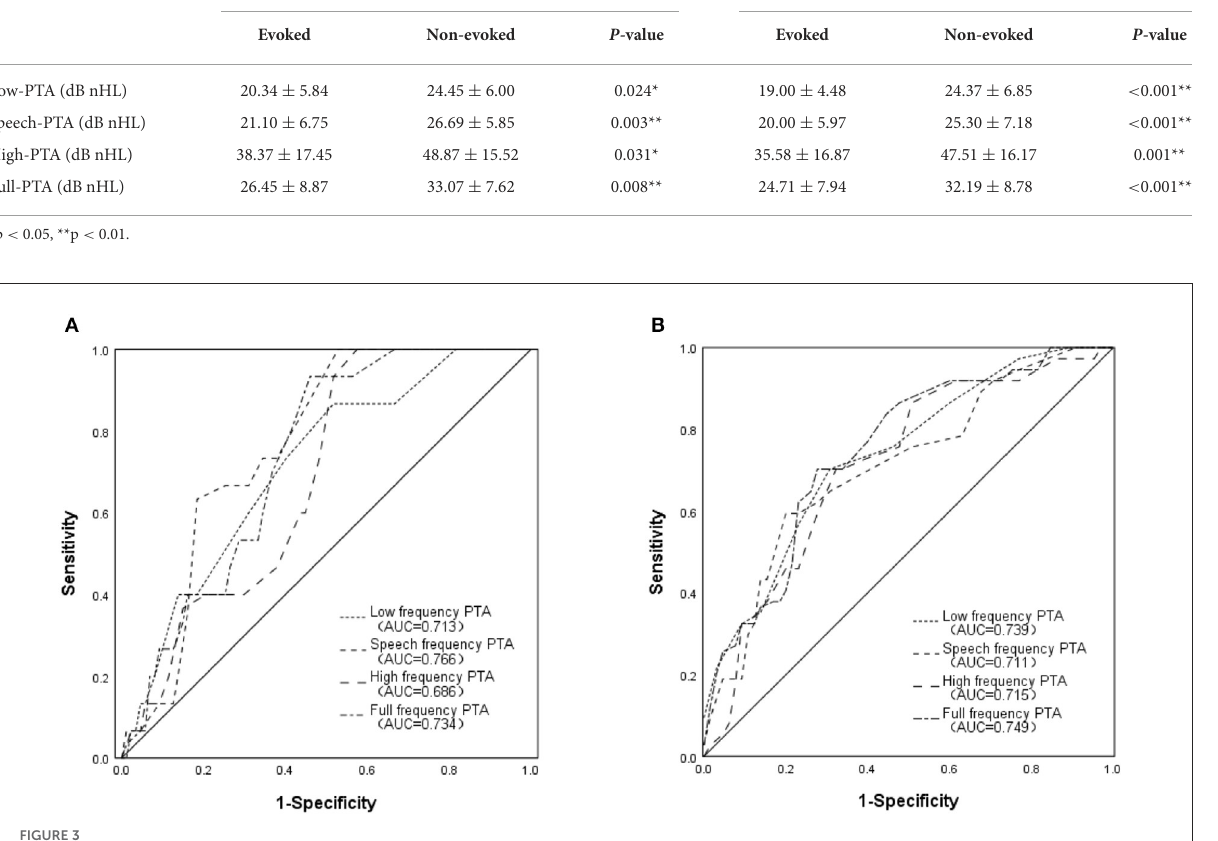
FIGURE3 Receiver operating characteristic curves of PTAs at different frequency bands in predicting ipsilateral otolith organ dysfunction (A) Evaluating saccular function by predicting whether cVEMP waveforms could be elicited; (B) Evaluating utricular function by predicting whether oVEMP waveforms could be